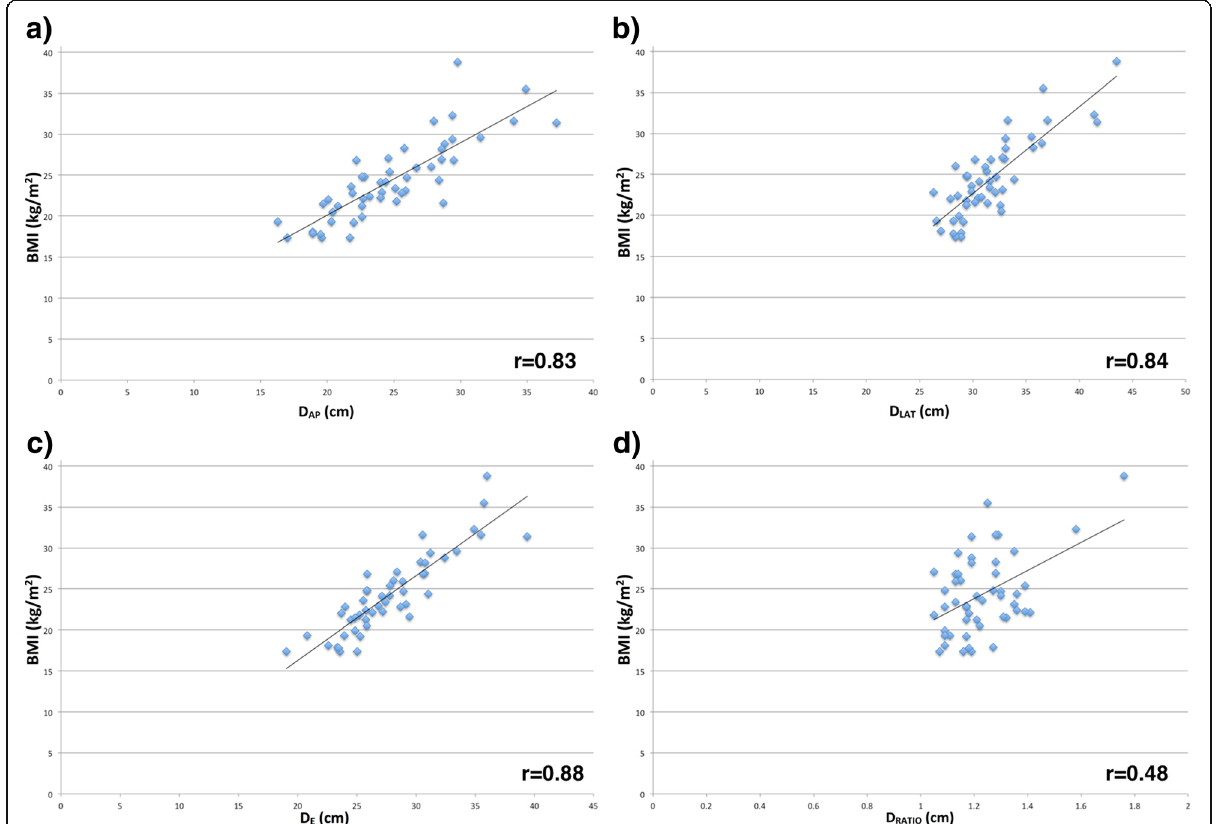
Fig. 2 Graphs show the relationship of body mass index (BMI) to anteroposterior diameter ( D AP ) ( a ), lateral diameter ( D LAT ) ( b ), effective diameter ( D E ) ( c ) and effective diameter ratio ( D RATIO ) ( d ). Correlation coefficients were 0.83, 0.84, 0.88, and 0.48, respectively ( p <